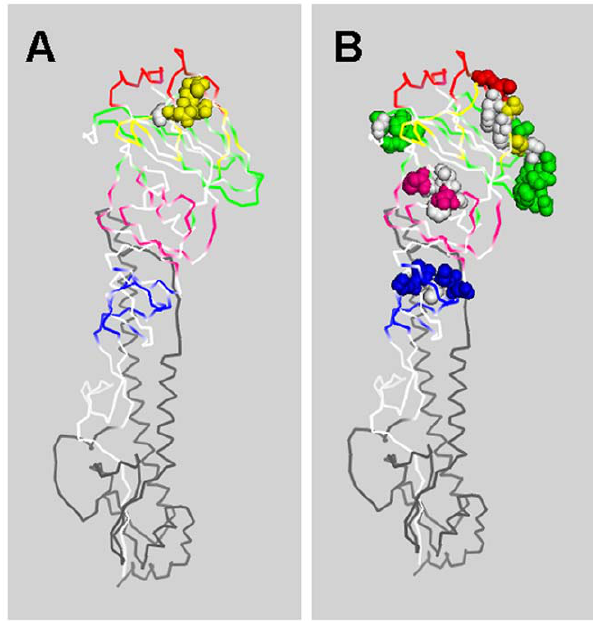
Figure 3. Location of most frequently occurring variants on 3D structure. Amino acids in the epitopes of the ribbon diagram of the HA protein from the related H3N2 strain X31 was colorized such that Epitope A=Yellow, B=Red, C=Blue, D=Green, and E=Pink. Amino acid residues with the highest frequency of variation are shown as balls. Panel A shows mutations from naı¨ve Guinea pigs and Panel B from immunized animals. Figure drawn using PyMOL from 2VIR.pdb [19].